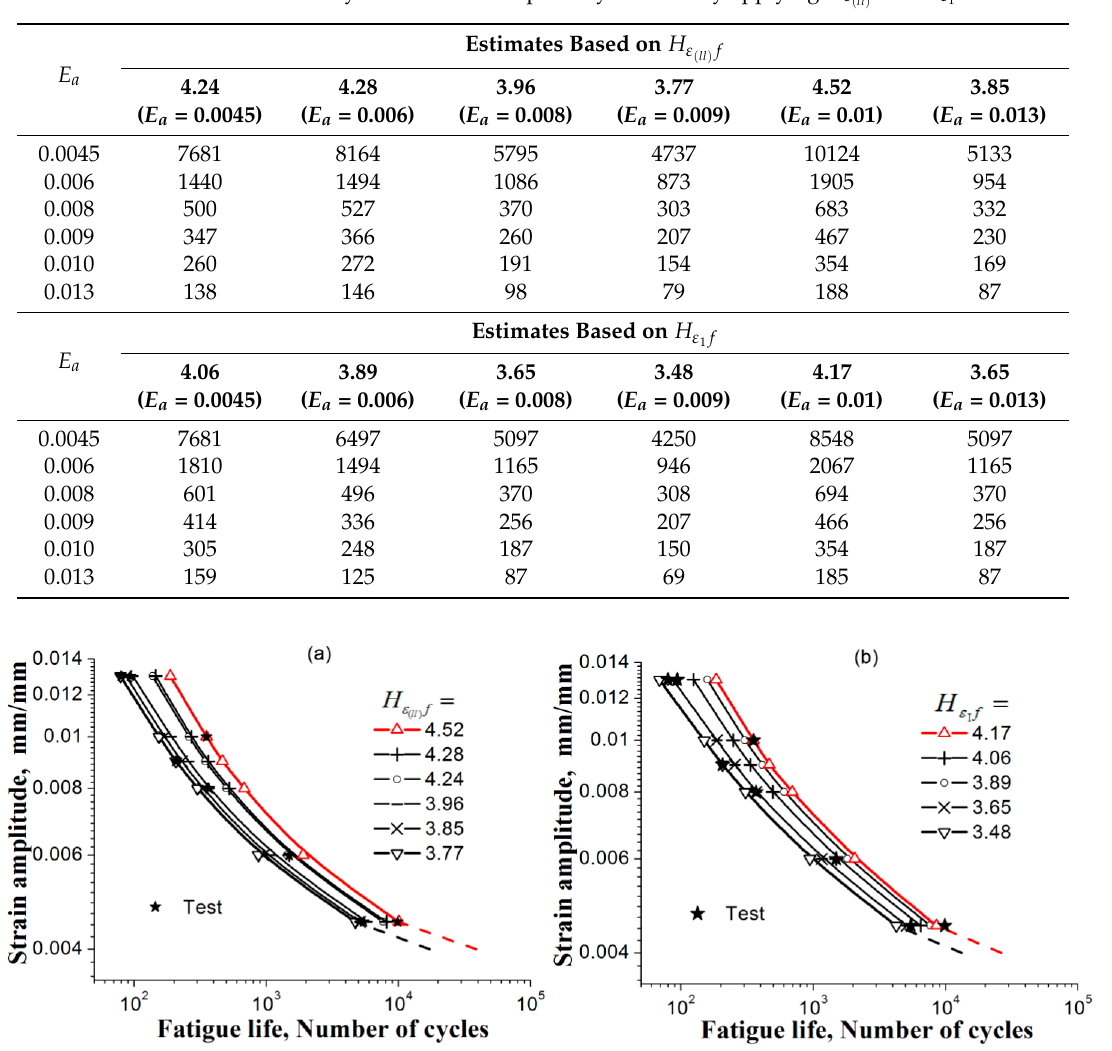
and H ε as FIP. ( ll ) 1 H H as ε and ε )( ll 1